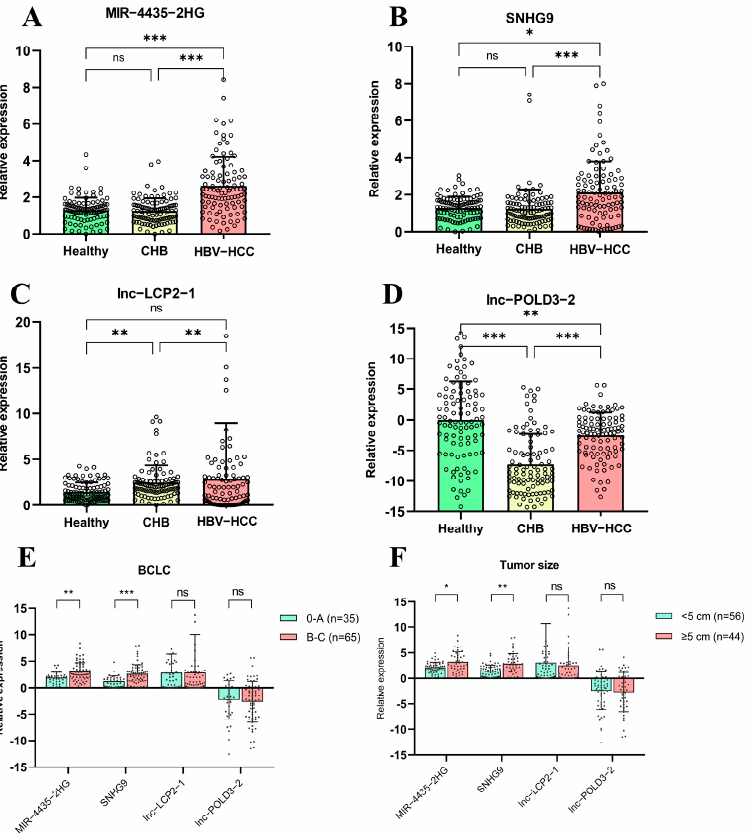
Figure 2. Relative expression of lncRNAs in PBMCs of healthy controls, patients with CHB and patients with HBV-HCC ( A ) MIR4435-2HG , ( B ) SNHG9 , ( C ) lnc-LCP2-1 , ( D ) lnc-POLD3-2 , ( E ) Association of lncRNAs with BCLC stage (0-A vs. B-C) in patients with HCC, ( F ) Association of lncRNAs with tumor size (<5 cm vs. ≥ 5 cm.) in patients with HCC. * p < 0.05, ** p < 0.01, *** p < 0.001.